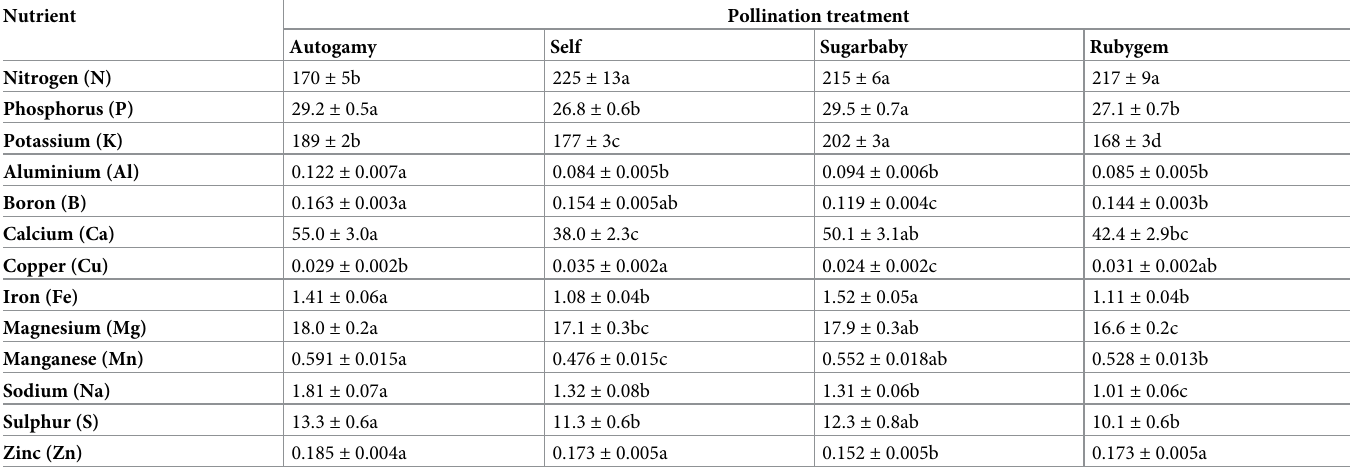
Table 2. Mineral nutrient concentrations (mg/100g fresh mass) in Redlands Joy strawberry fruit arising from unassisted self-pollination (Autogamy) or hand-polli- nation with self-pollen (Self) or cross-pollen from another cultivar (Sugarbaby or Rubygem). Nutrient Pollination treatment Autogamy Self Sugarbaby